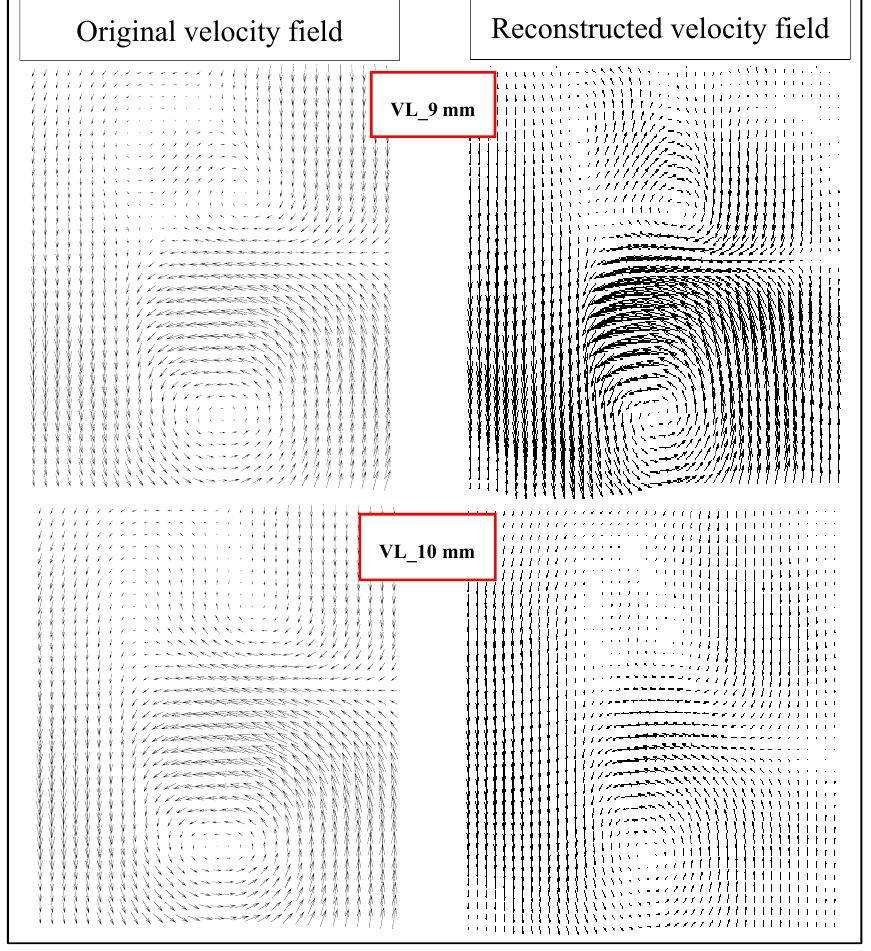
Figure 11. Reconstructed velocity field versus original velocity field for 9 mm and 10 mm valve lifts